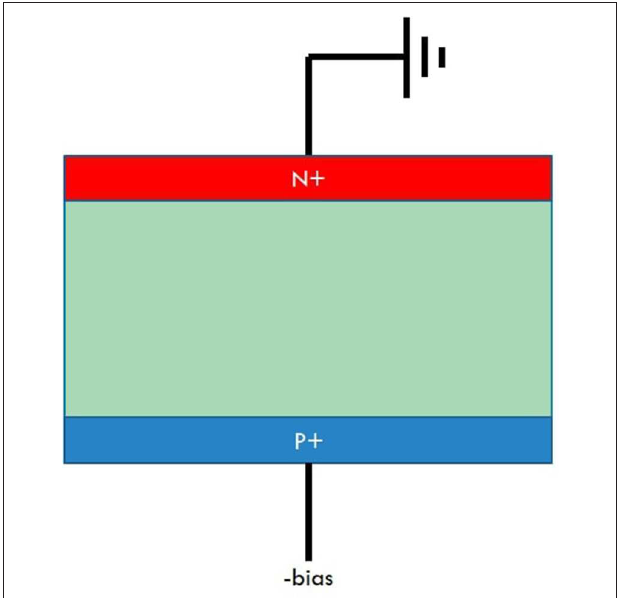
FIGURE 2 | n-i-p structure of the a-Si:H diode. The n-type (red) and p-type (blue) layers are 90 nm thick and the intrinsic (green) layer is 30 µ m thick.